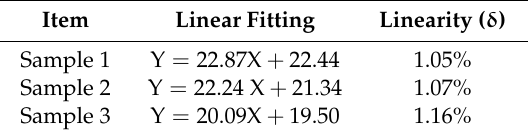
Table 2. Linear fitting results of three di ff erent filament